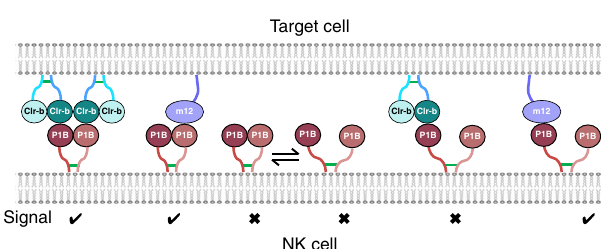
Fig. 6 Avidity-based model of NKR-P1B receptor function. NKR-P1B must be dimeric to recognize Clr-b, whereas recognition of m12 is independent of NKR-P1B self-association. Green lines indicate disul fi de